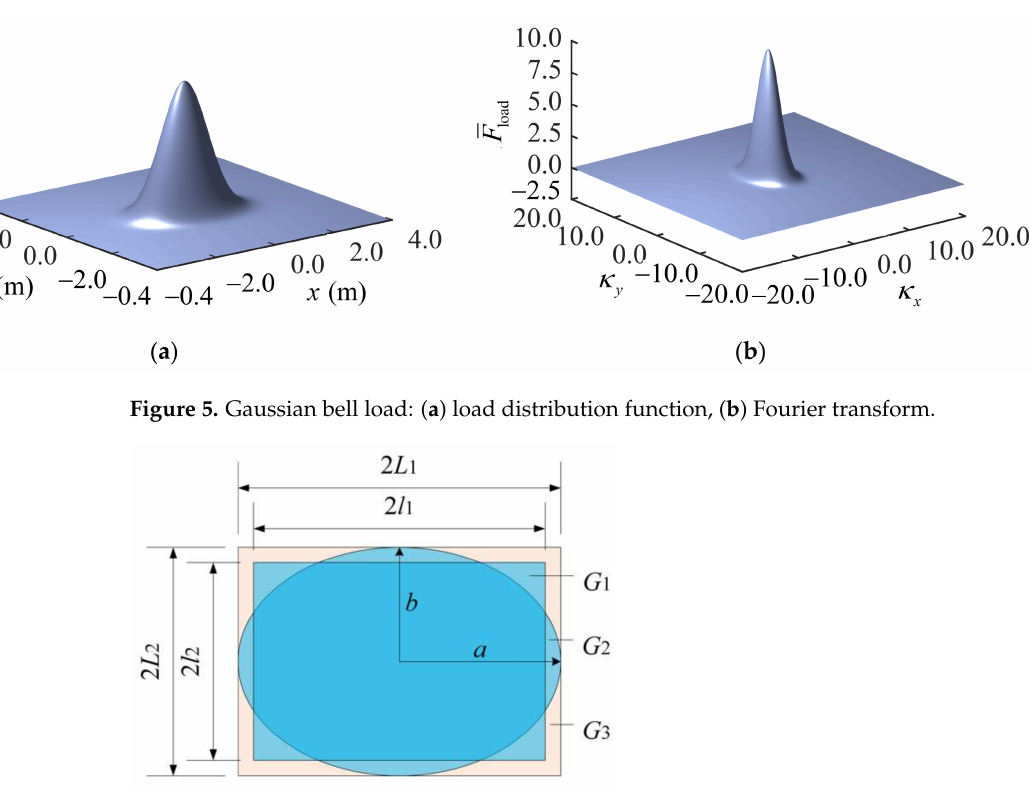
Figure 6. The equivalent conversion